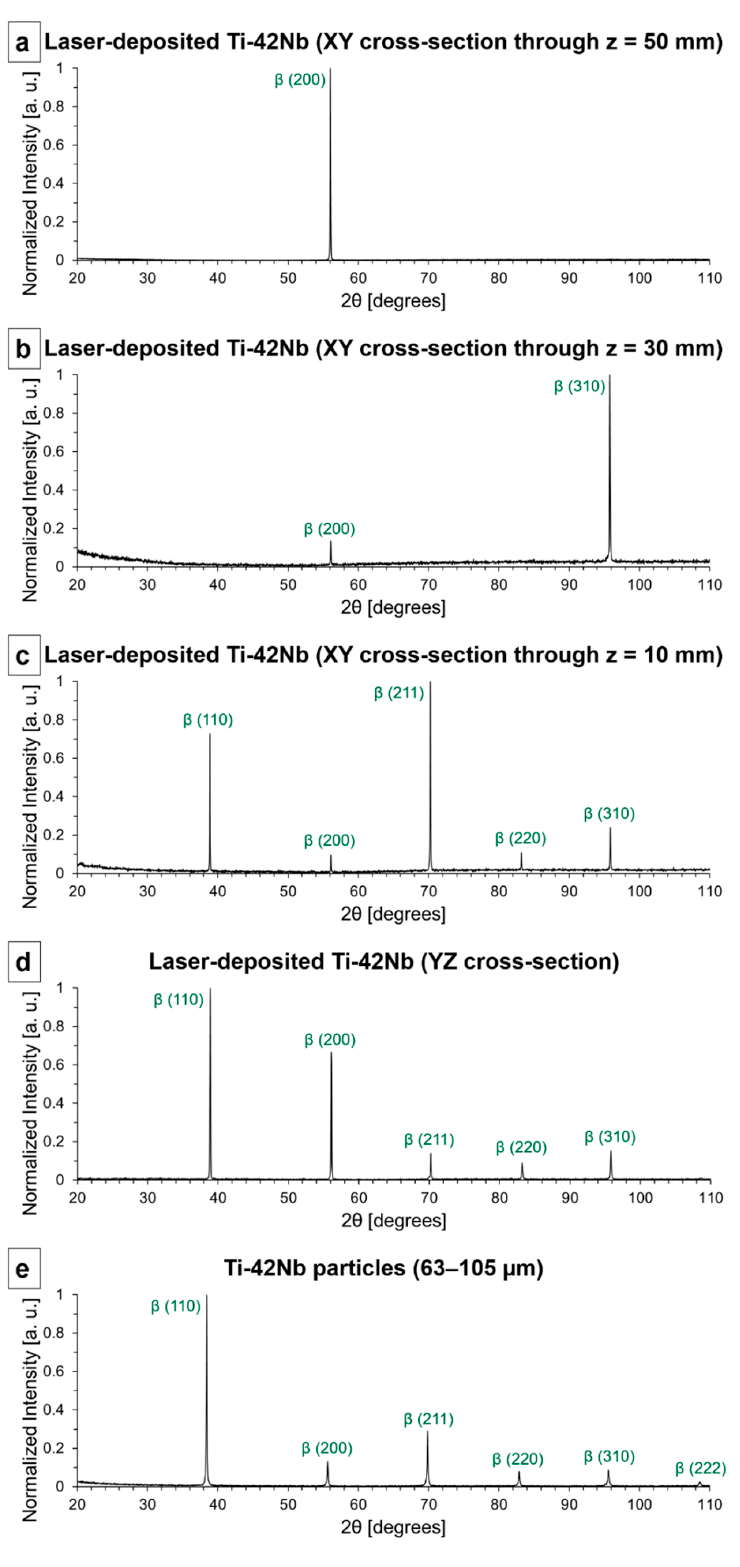
Figure 7. X-ray diffractograms: ( a ) laser-deposited Ti-42Nb (XY cross-section through z = 50 mm), ( b ) laser-deposited Ti-42Nb (XY cross-section through z = 30 mm), ( c ) laser-deposited Ti-42Nb (XY cross-section through z = 10 mm), ( d ) YZ cross-section, and ( e ) spherical pre-alloyed Ti-42Nb particles (63–105 µm).